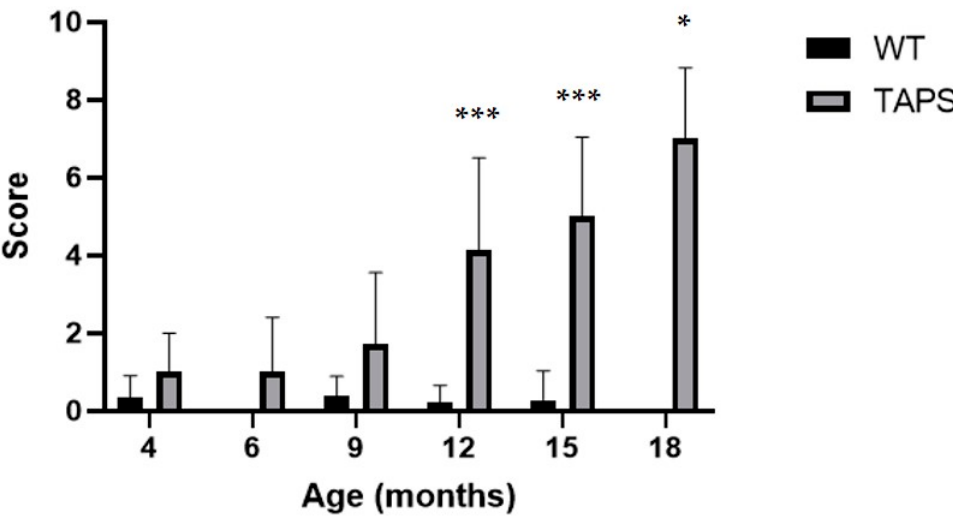
Figure 5. TAPS mice had age-dependent phenotypic alterations in the SHIRPA test. Shown are the mean scores of animals from each age group with SEM for TAPS and wild-type (WT) mice. A significant increase of SHIRPA scores was found for 12- (*** p = 0.0001, TAPS n = 16, WT n = 9), 15- (*** p = 0.0002, TAPS n = 11, WT n = 7), and 18- (* p = 0.0273, TAPS n = 4, WT n = 3)-month-old TAPS compared to their WT littermates. Scores of WT remained widely unchanged over time. For the statistical analysis, mixed effects analysis with Sidak´s post-hoc was used to compare the age and genotype. For all animal numbers per age, see Table 1. Data is given as mean + SEM.